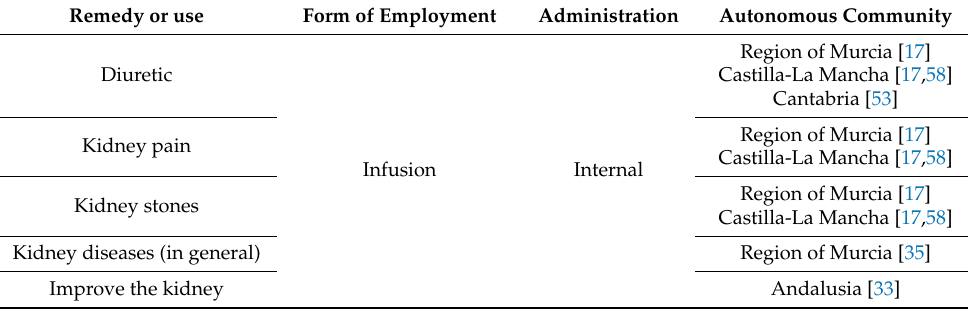
Table 3. Compilation of the medicinal uses of Chiliadenus glutinosus as a remedy for diseases of the genito-urinary system in Spain, compiled from the existing specific